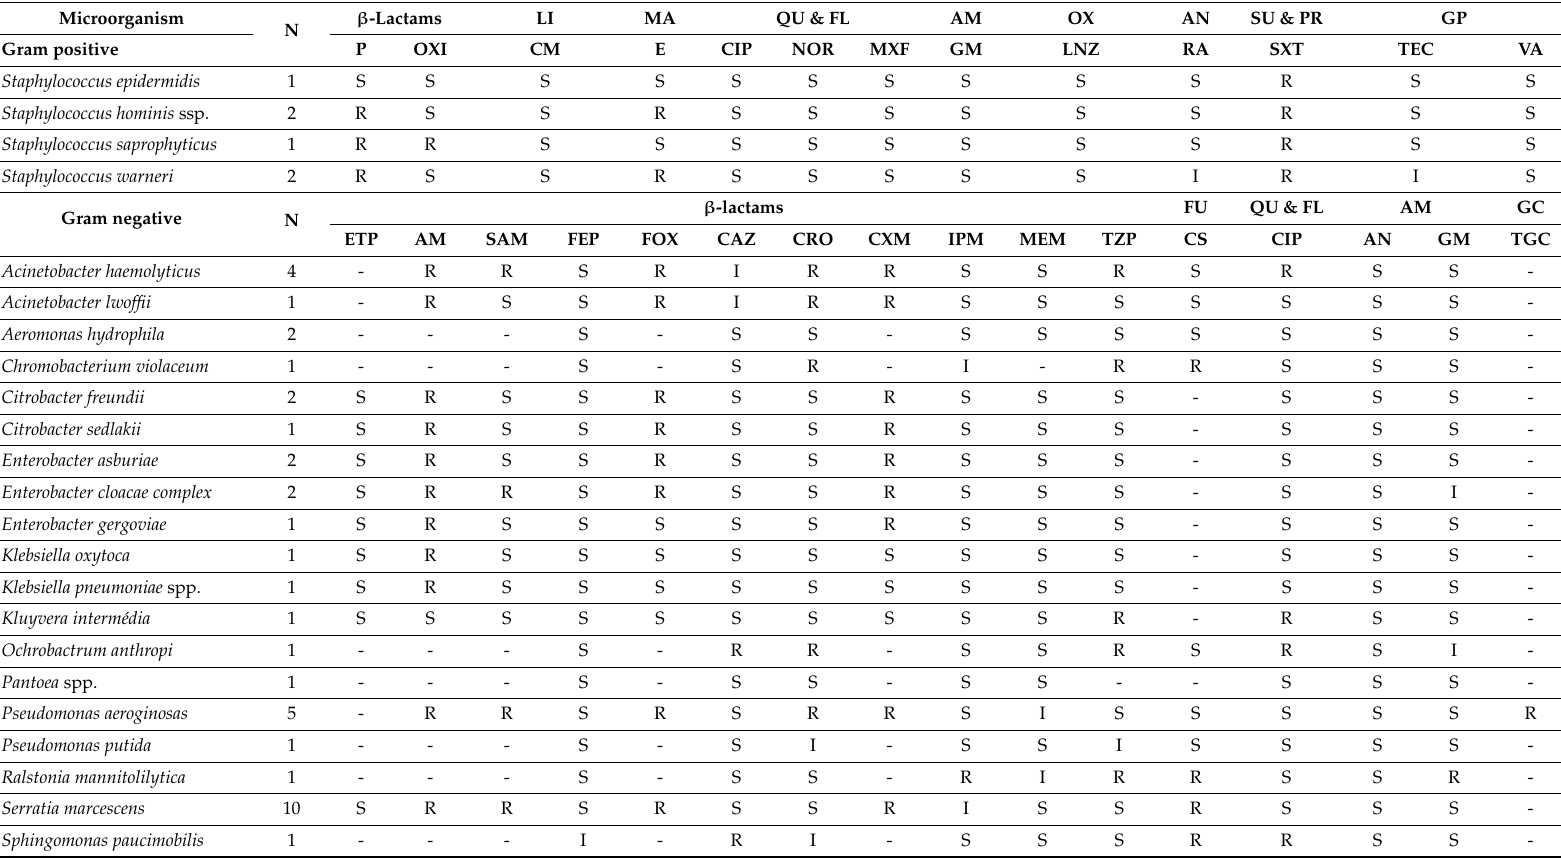
Table 4. Antimicrobial resistance and identification by the VITEK system of 45 bacteria isolated from well